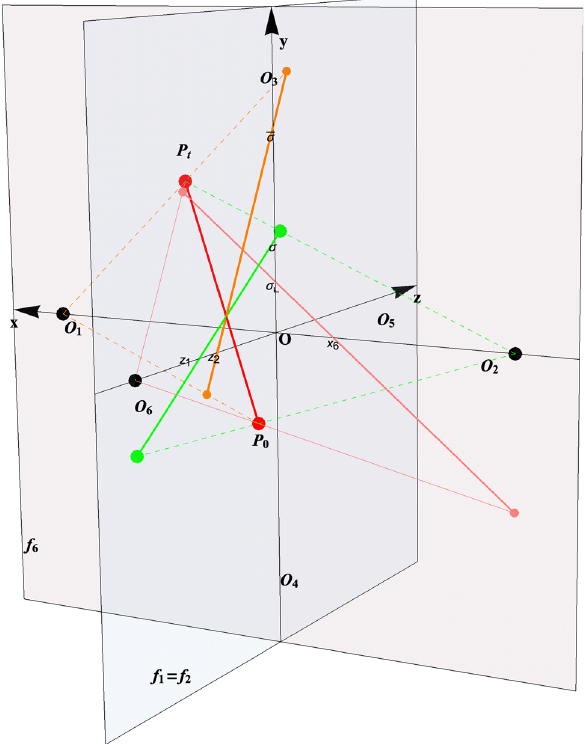
Fig. 5 Stereographicprojectionsofagivensegment(inred)fromthree different poles O 1 , O 2 , O 6 . O 1 and O 2 are on the same x -axis, sym- metrically placed at the distance ± a from the origin. The third pole O 6 is at − a on the z -axis. The red segment P 0 P 1 indicates a light track, whose projections are indicated in green and orange on the plane z − y andinpinkontheplane x − y .Theothervisualpoleshavebeenindicated for future